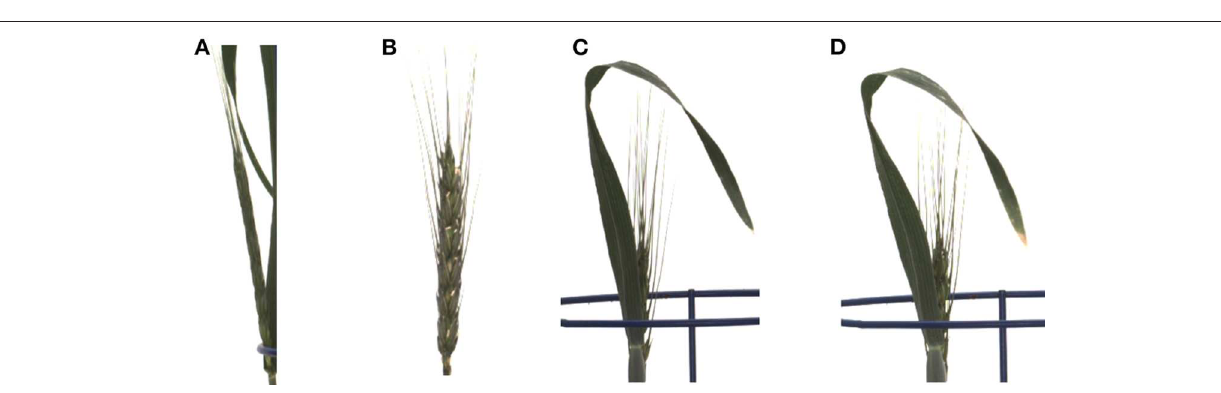
FIGURE 7 | Limitations of the proposed method. (A) The early-stage spike texture failed to be detected in plant ID 1817KN373. (B) The detected spike texture in plant ID 1817KN373. (C) Example spike geometry less than the BBCH55 scale in plant ID 1817KN412. (D) Spike geometry according to the BBCH scale in plant ID